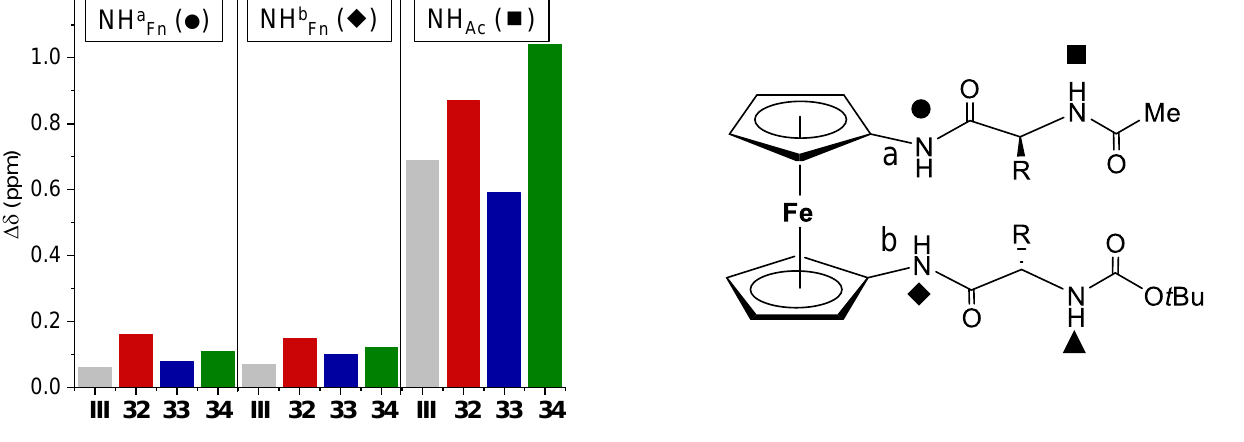
Figure 4. Changes in chemical shifts ( Δδ ) observed for NH Fn and NH Ac in peptides 32 − 34 at high (50 mM) vs. low concentrations (6.25 mM).